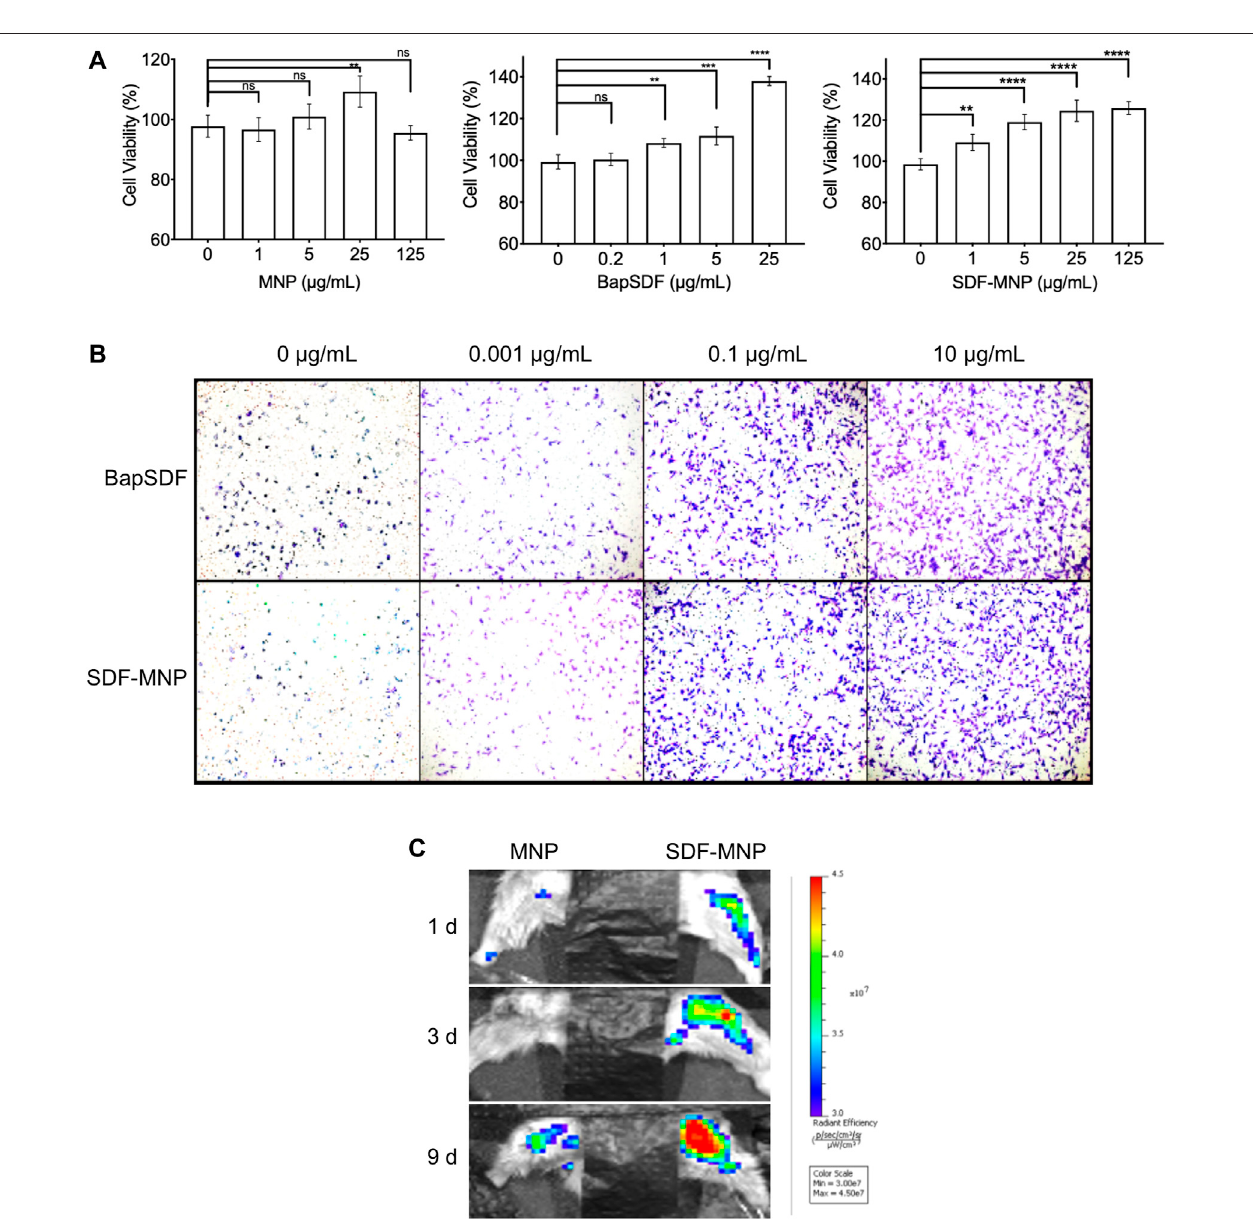
FIGURE5| ToxicityandchemotaxisofSDF-MNP. (A) ViabilityofiPSC-MSCstreatedwithdifferentconcentrationsofMNP,BapSDF,andSDF-MNP. (B) Transwell assay for iPSC-MSCs incubated with SDF-MNP. Cells that crossed the membrane and attached on the SDF-MNP side were stained using the crystal violent reagent (magni fi cation: ×100). (C) Recruiting ability was estimated by the intensity ofthe labeled iPSC-MSCs at the bone fracture site. The number of aggregated iPSC-MSCs in SDF-MNP treatment (Right) increased from the blue to red signal while lower signal increasing for MNP without SDF treatment (Left). SDF-MNP showed low cell toxicity and demonstrated chemotactic ability for